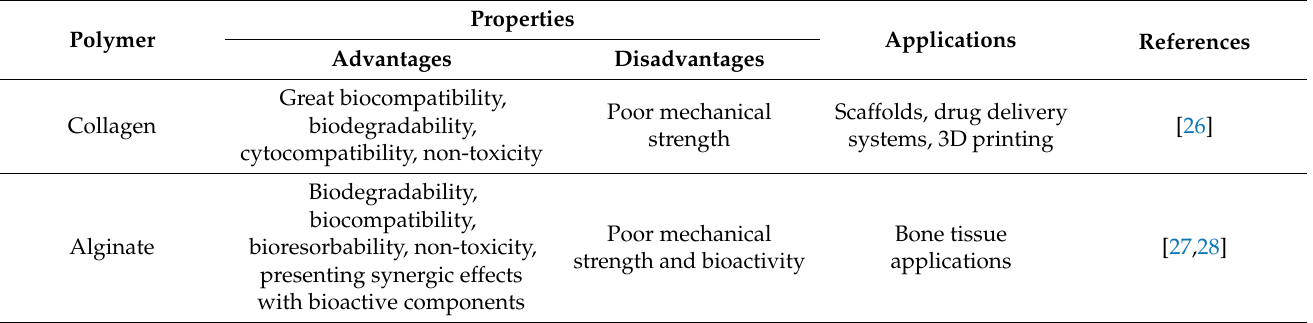
Table 1. General characteristics of natural polymers and their applications in